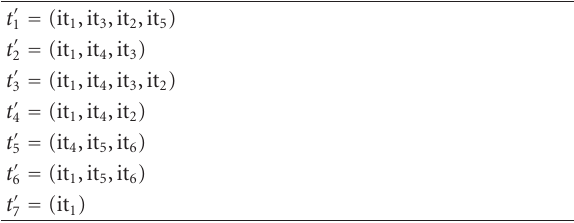
Table 8: A selected and sorted transaction